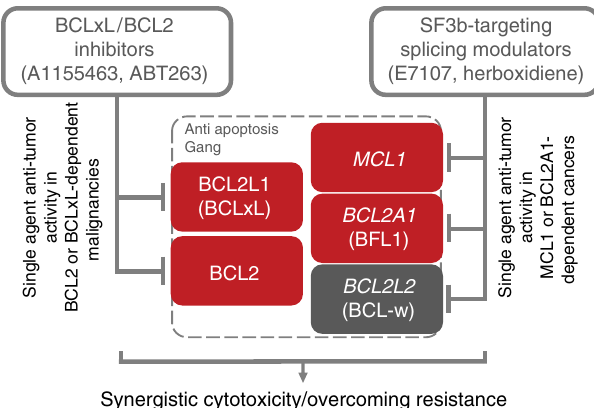
Fig. 7 Mechanism of combinatory activity between SF3b-targeting splicing modulators and BCLxL/BCL2 inhibitors. SF3b-targeting splicing modulators preferentially perturb the RNA splicing of MCL1 and BCL2A1 but not BCL2L1 (BCLxL), leading to selective cytotoxicity in MCL1- or BCL2A1-dependent cancer cells. In combination with BCLxL/BCL2 inhibitors,